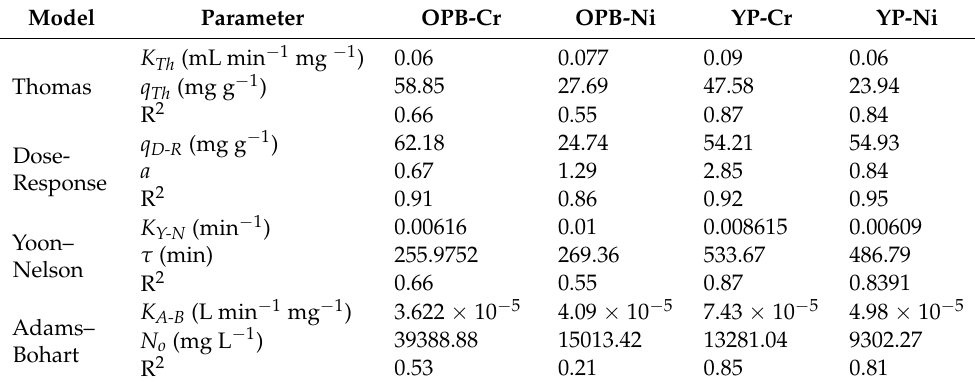
Table 6. Adjustment parameters for Cr(VI) and Ni(II) adsorption on OPB and YP using non-linear